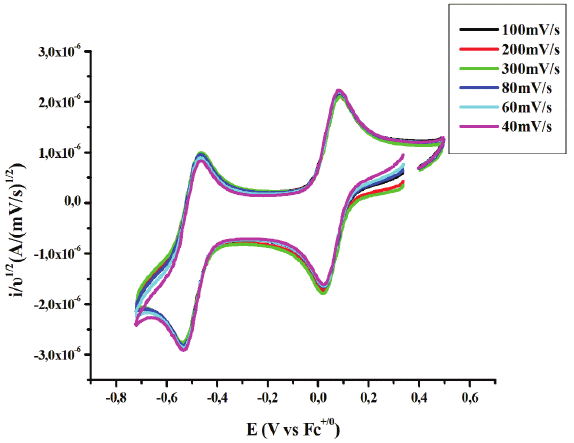
Figure 5: Emission & excitation spectra of complex 2 in acetone, at room temperature.